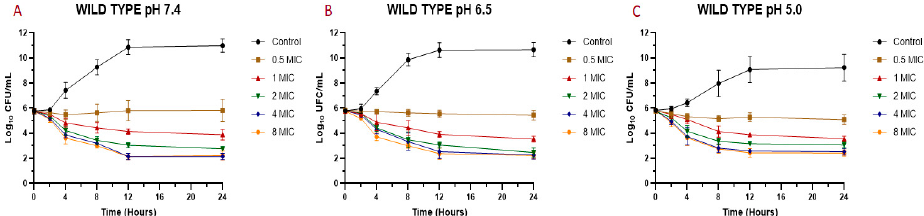
Figure 2. Time-kill curve for M. armillaris essential oil against S. aureus wild types ( n = 6, using the mean of triplicates for each strain) at pH 7.4 ( A ), 6.5 ( B ), and 5.0 ( C ).